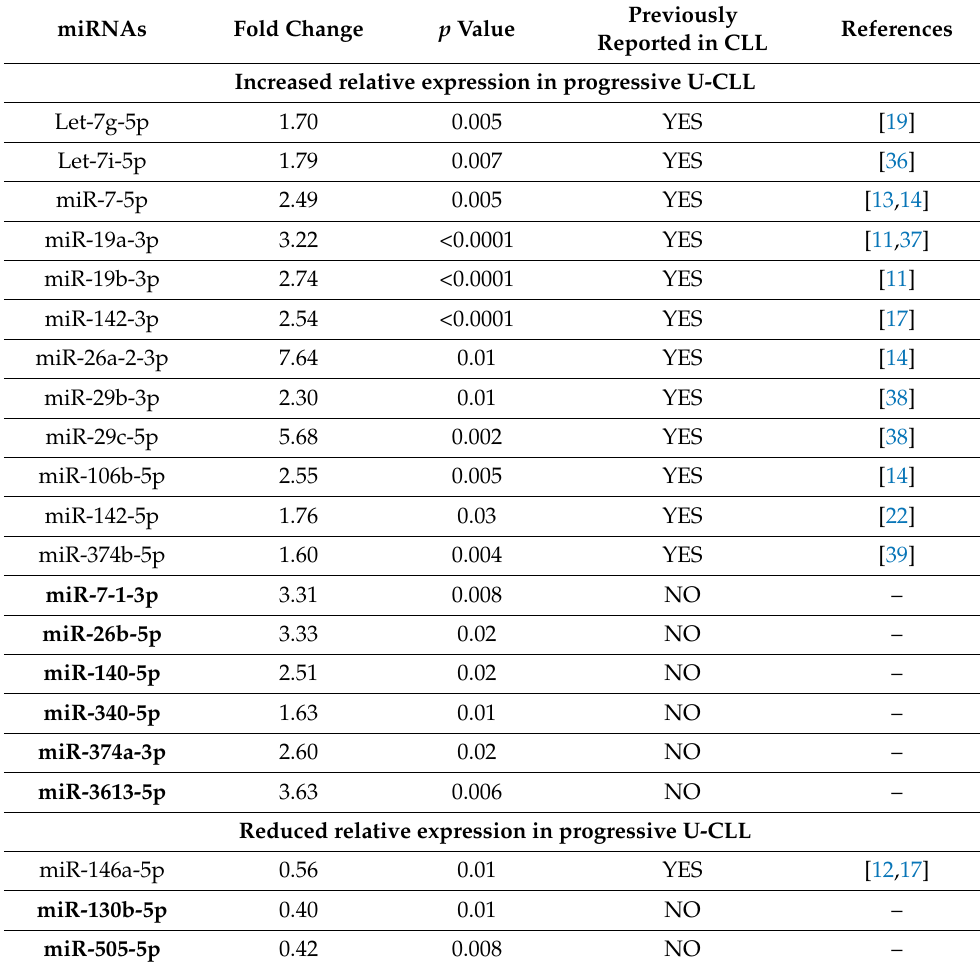
Table 2. List of the most differentially expressed miRNAs between progressive and indolent patients, p ≤ 0.05 in Volcano analysis. Fold changes, p -values, and the main bibliographical data reporting miRNAs previously described in CLL are provided. miRNAs Fold Change p Value